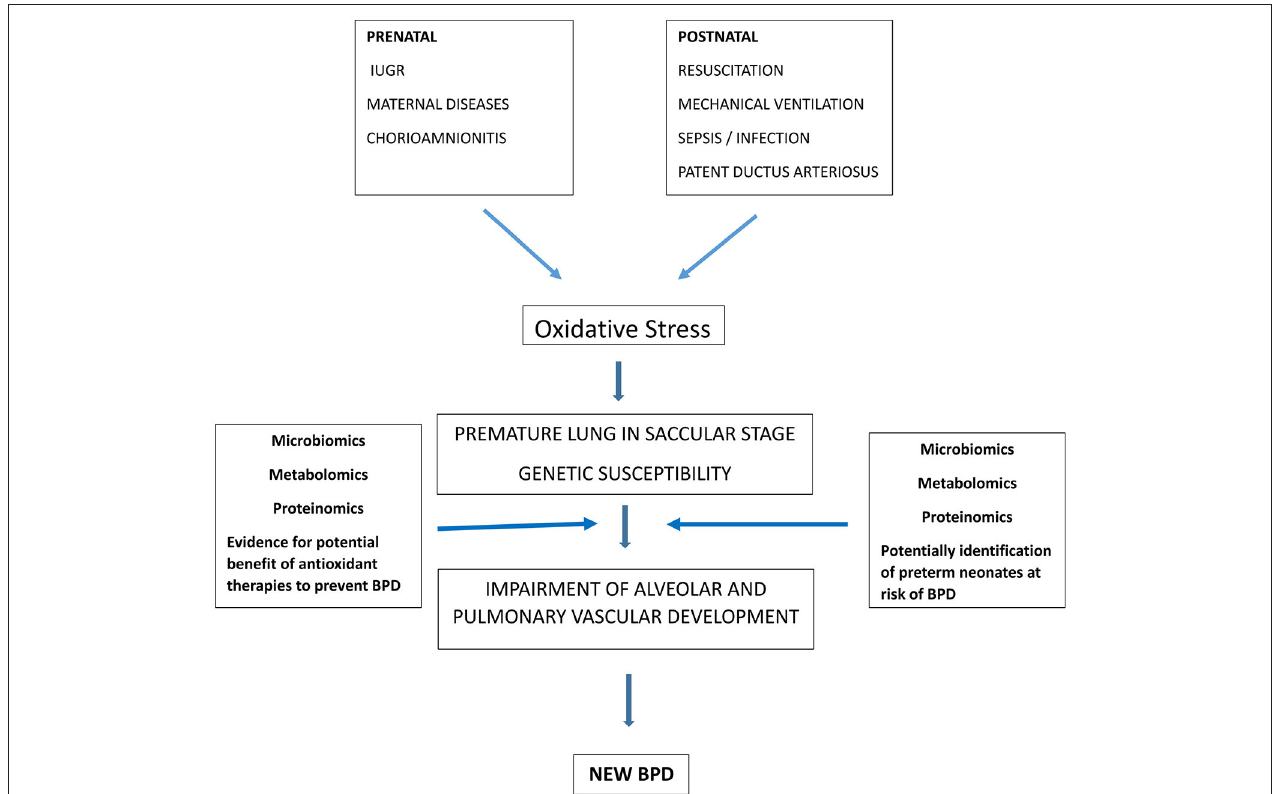
FIGURE 1 | Role of oxidative stress in BPD pathogenesis and contribution of “omic sciences” to identify preterm infants at risk of BPD and to demonstrate the rationale of therapies to reduce oxidative stress and potentially prevent BPD.